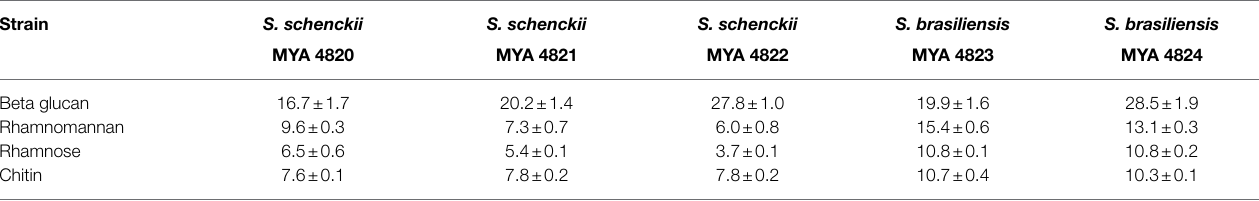
TABLE 3 | Cell wall polysaccharide content comparison of the Y phase of the S. schenckii and S. brasiliensis strains under study. Strain